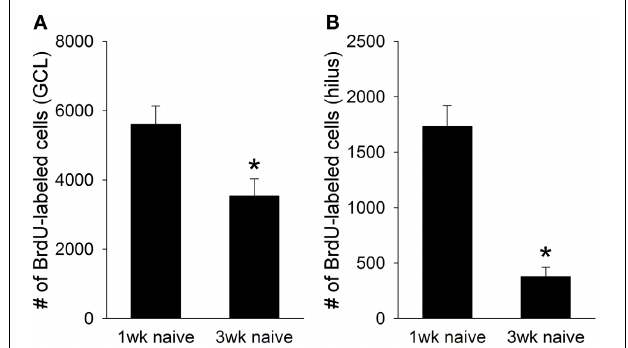
FIGURE 1 | Naïve animals perfused one week after the BrdU injection ( N = 6) retained approximately 7,500 BrdU + cells in the total dentate gyrus. However, naïve animals perfused three weeks after the BrdU injection ( N = 10) retained fewer than 4,000 cells, indicating that nearly half of the cells generated in the juvenile dentate gyrus undergo cell death between the first and third week of their birth. This cell death was evident in both (A) the granule cell layer (GCL), where nearly 40% of the new cells died, and (B) the hilus, where 80% died. Asterisk indicates p ≤ 0 . 05.